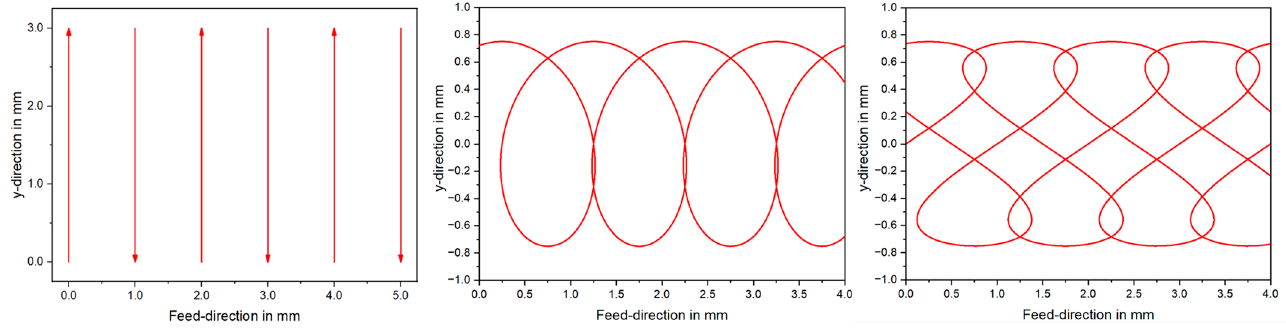
mm, v f = 10 mm/s, and f = 20 Hz Figure 3. Overlap welding strategies for copper-aluminum welds used in the experimental investigation: linear stitched weld ( a ), circular beam oscillation ( b ), and vertical eight beam oscillation ( c ). The linear stitched weld is characterized by single lines of l = 3 mm length. These single lines were arranged at a horizontal distance of 1 mm, welded in alternating y-direction. In order to symmetrically distribute the energy input, the first seam is placed at x = 16 mm in positive y-direction, followed by two seams at x = 15 mm and 17 mm in negative y-direction. This stitching was then repeated 15 more times in alternating y- direction. The laser beam trajectories of the circular and vertical eight oscillation can be characterized by Equations (1) and (2) respectively. The trajectory of the laser beam using circular motion in superposition to a global linear feed rate is described by Equation